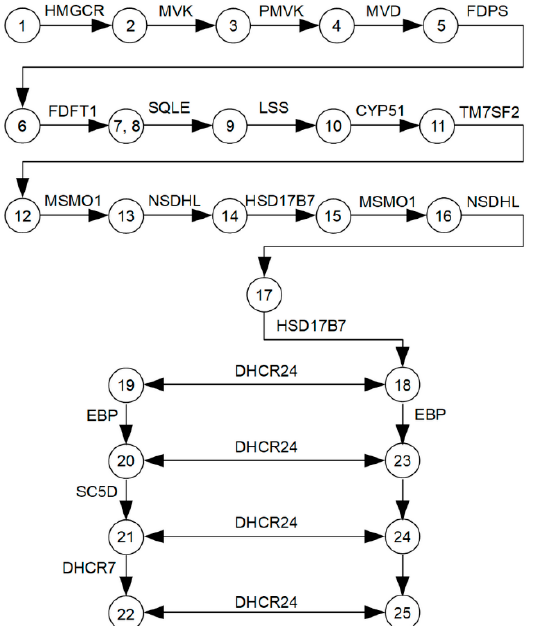
Figure 1. A logical scheme of enzymes and metabolites involved in the cholesterol synthesis pathway. The following metabolites are indicated by numbers: (1)—hydroxymethylglutaryl ‐ CoA; (2)—